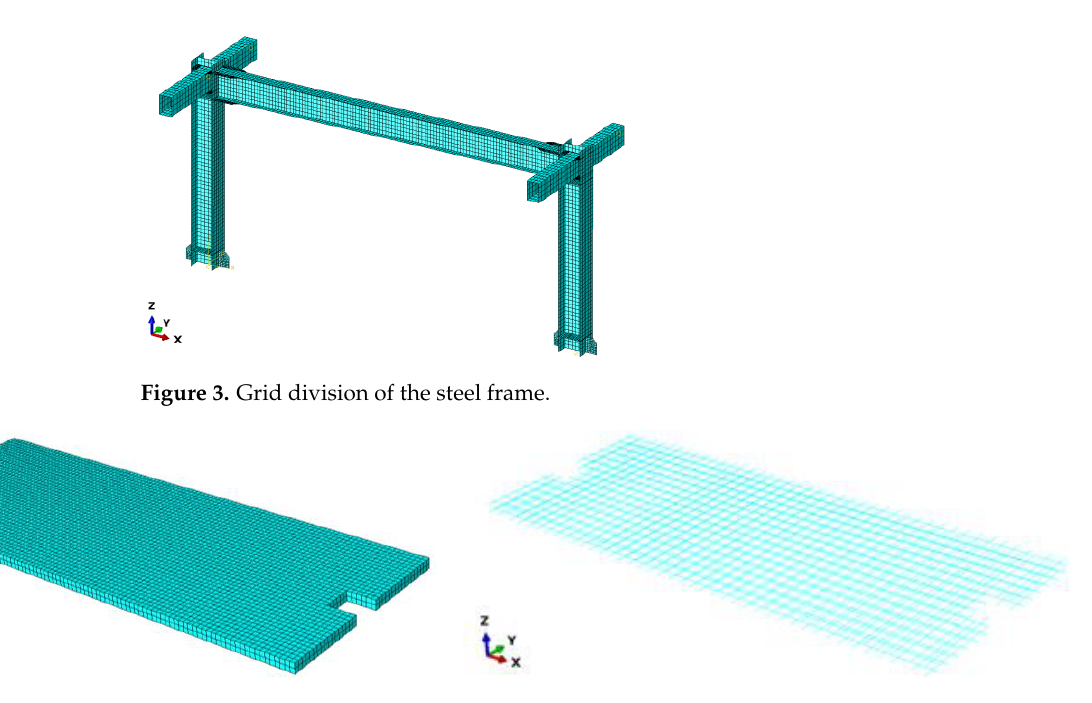
Figure 4. Grid division of reinforced concrete slab.